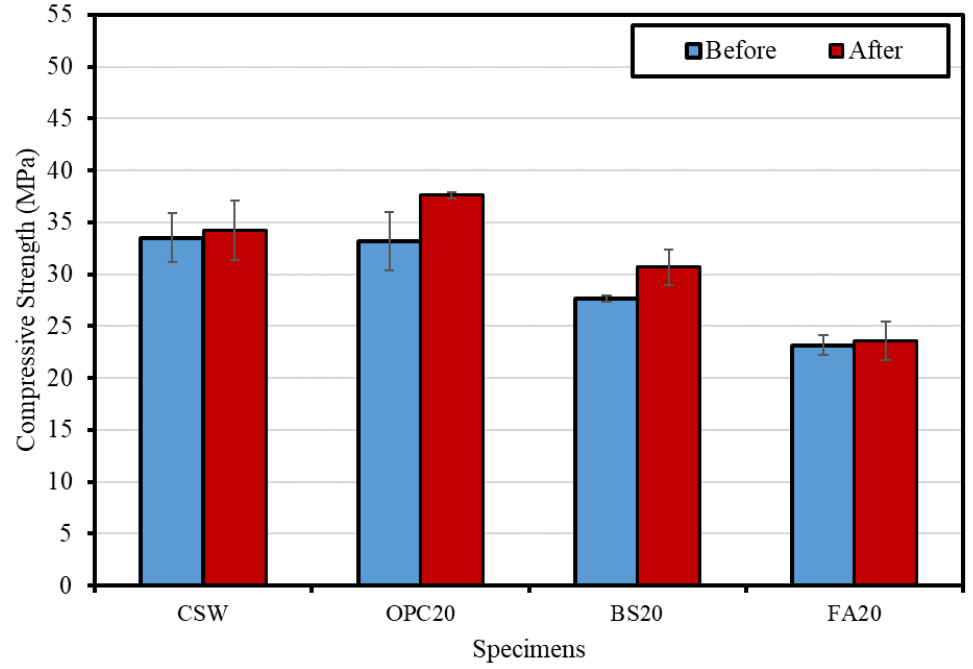
Figure 14. Compressive strengths before and after Lean Carbonation for different mixtures.